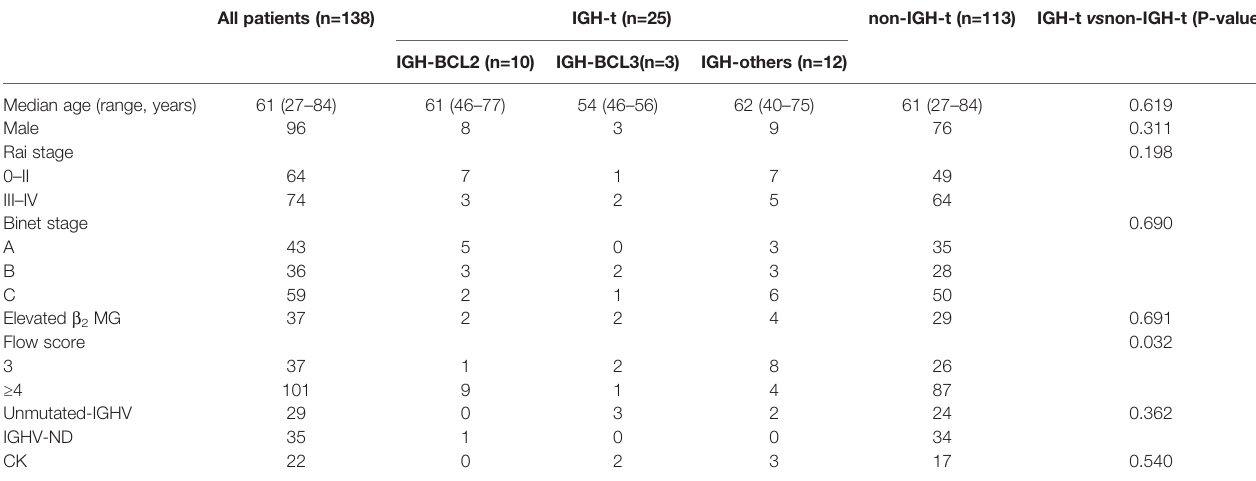
TABLE 2 | Baseline characteristics of all patients with CLL and those in the IGH-t (IGH-BCL2, IGH-BCL3, IGH-others) and non-IGH-t groups. All patients